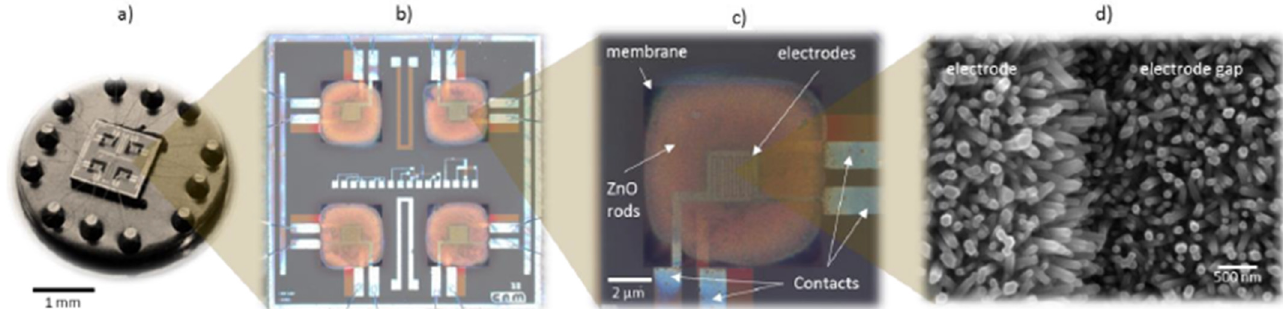
Figure 27. Photograph of the micromachined gas sensor device mounted on a standard TO-8 package ( a ). Optical microscope imaging of the four micromachined sensors in the array and ( b ) detailed view of a single sensor; ( c ) images were obtained using polarized filters to provide better contrast among the ZnO rods (orange), the electrodes (yellow), SiO 2 /Si 3 N 4 micromachined membrane (black) and SiO 2 /Si bulk (grey). ( d ) SEM imaging of the aerosol-assisted chemical vapour deposited ZnO rods into the micromachined platform, showing the edge of an electrode [121]. Copyright (2018), with permission from Elsevier.